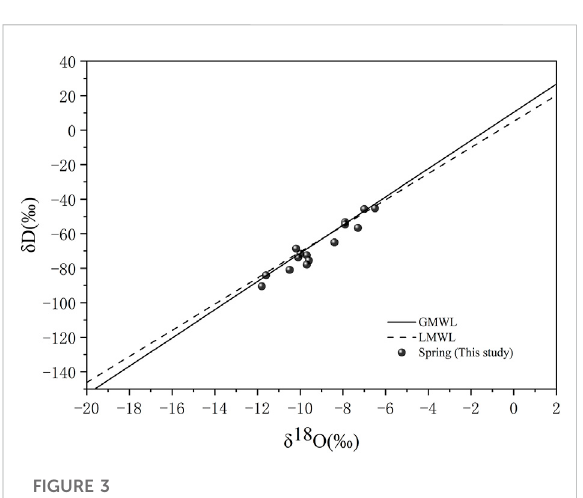
FIGURE 3 Distribution chart of δ D and δ 18 O in the water